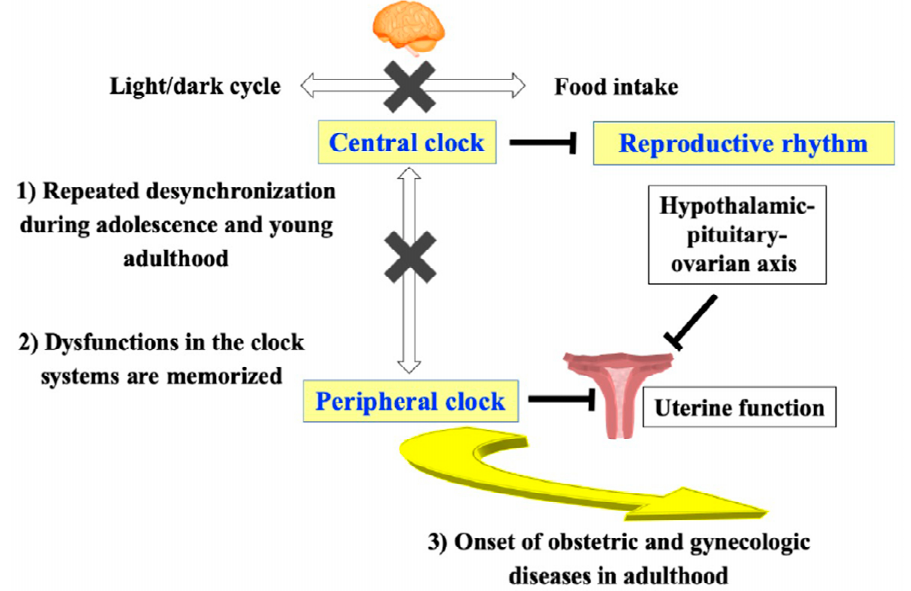
Figure 2. The involvement of central and peripheral clock systems in ADHOGD. Adverse dietary habits continue to desynchronize central and peripheral clocks during the critical period, from adolescence to young adulthood (1). This functional disturbance in the clock systems is memorized in the hypothalamic-pituitary-ovarian axis and the uterus from the developing to mature stages (2). This will lead to the onset of obstetric and gynecologic diseases in adulthood (3).